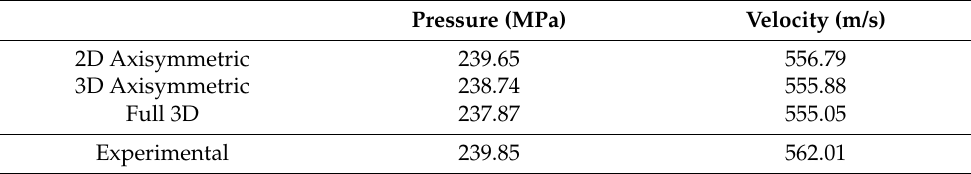
Table 1. Results for absolute pressure and velocity of the projectile for simulations compared to experiments from [10].